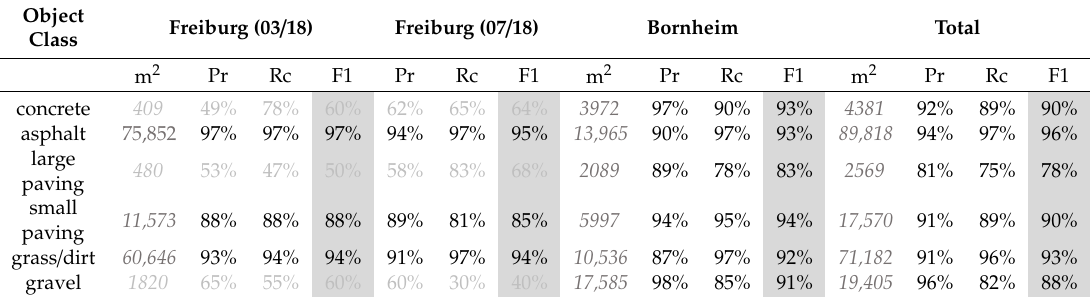
Table 3. Results for all surface classes on all three evaluations sets with size of ground truth data in m2 for each class. Note that the ground truth sizes for three classes (concrete, large paving, and gravel) is very small on the Freiburg set, and the numbers are therefore not reliable (indicated in grey font).